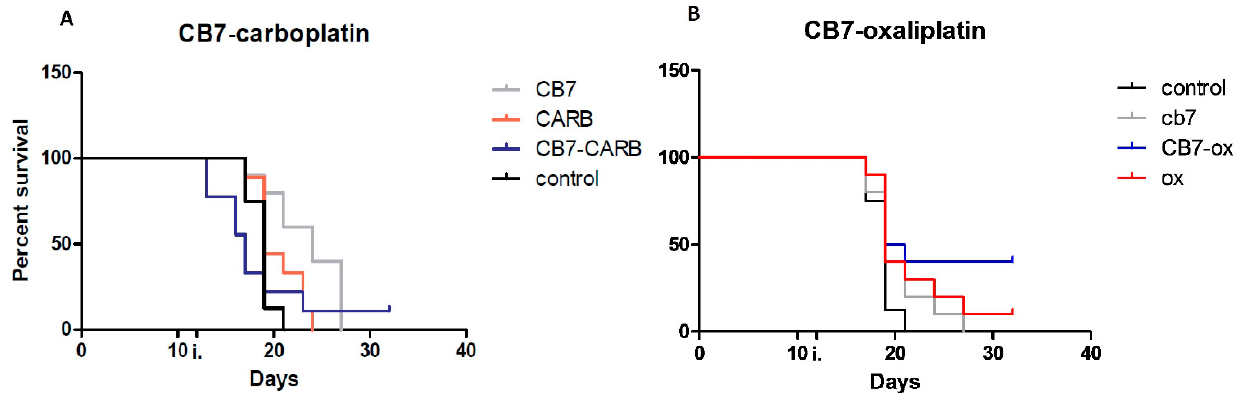
Figure 6. Effects of the CB[7] and platinum drugs on mice survival in melanoma model. ( A ) Impact of the mixture of CB7 and carboplatin (1:1) on mice survival. ( B ) Impact of the oxaliplatin–CB[7] complex on mice survival.